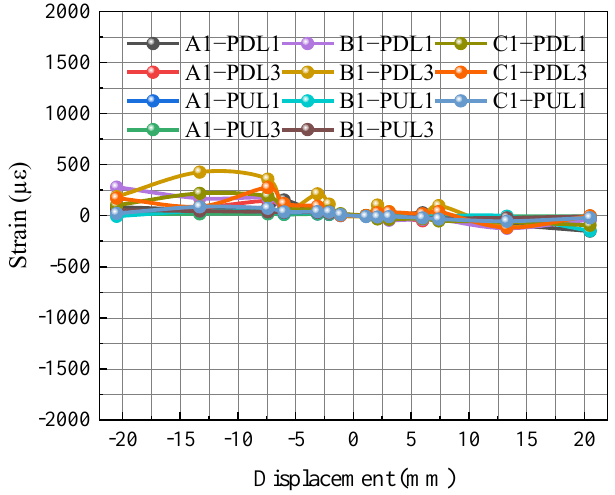
Figure 19. Strain of longitudinal bars in thick plates.